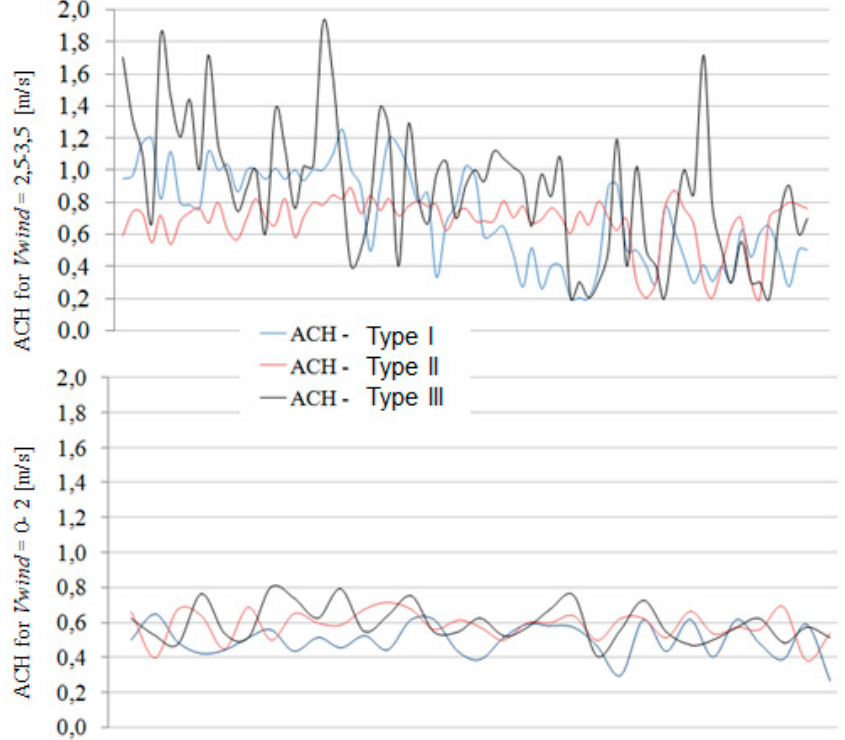
Figure 18. Summary of ACH results during windy and no windy periods.